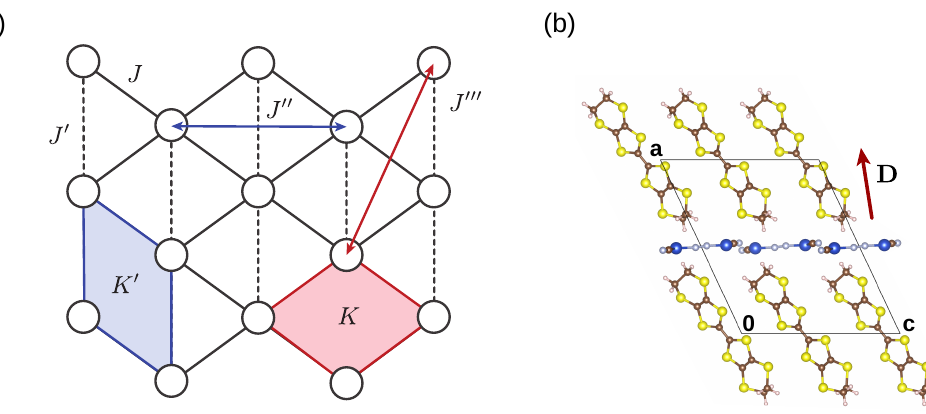
Figure 4. Magnetic exchange in κ -phase charge-transfer salts. ( a ) Heisenberg exchange terms J , J (cid:48) , J (cid:48)(cid:48) , J (cid:48)(cid:48)(cid:48) and four-spin ring-exchange K and K (cid:48) on the two distinct four-site plaquettes on the anisotropic triangular lattice. ( b ) The SOC-induced DM vector D is oriented approximately along the long side of the organic molecule, here illustrated for the example κ -(BEDT-TTF) 2 Cu 2 (CN) 3 . Figures reprinted from Refs.